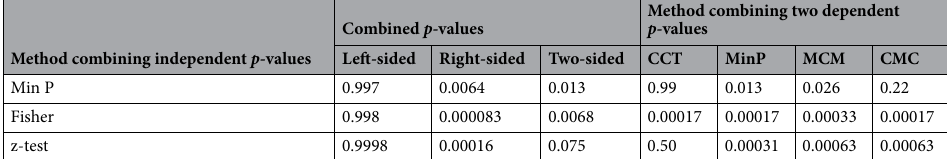
Table 3. Results from the tests applied to a real data application.